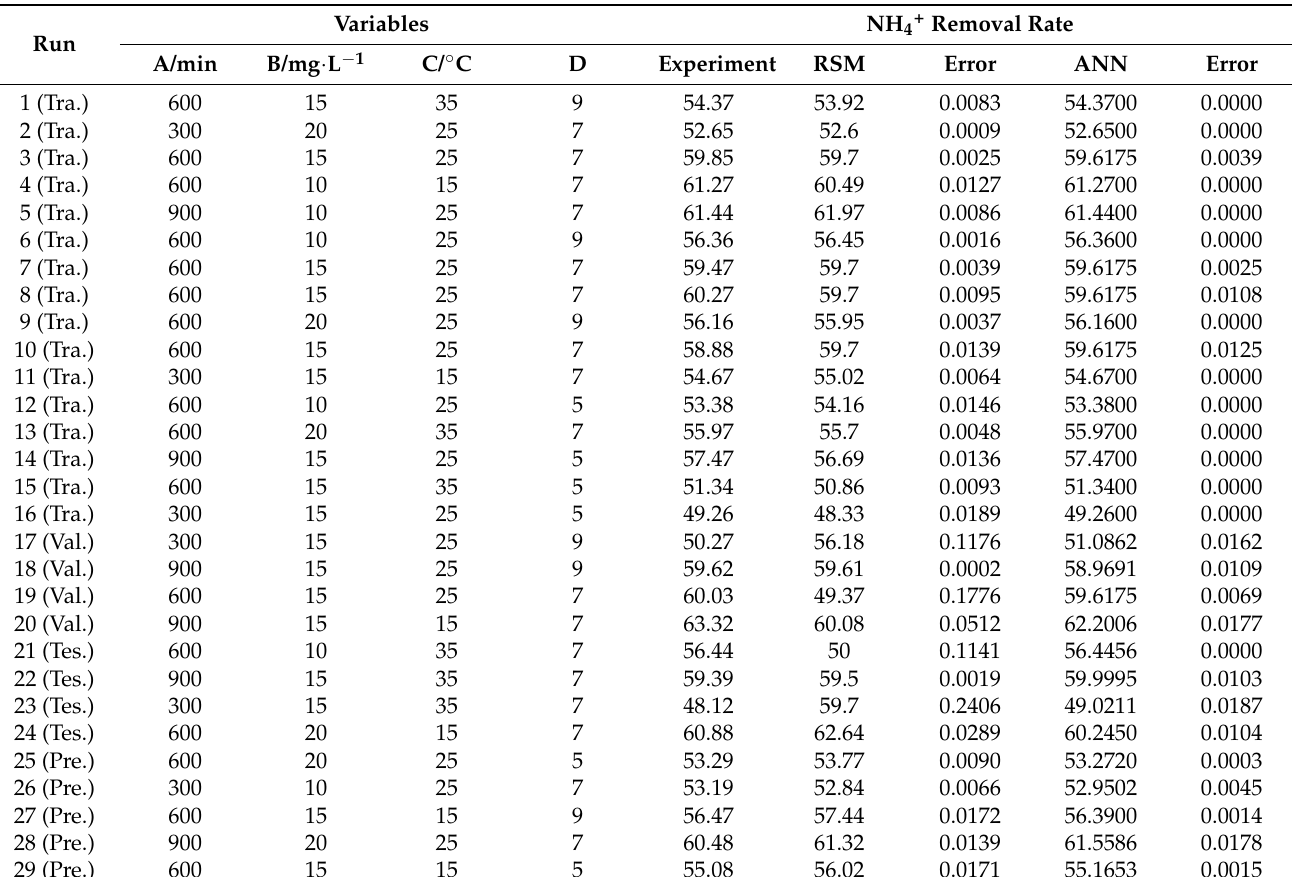
Table 7. RSM (response surface methodology) and ANN (artificial neural network) predicted results and errors, along with experimental values of the